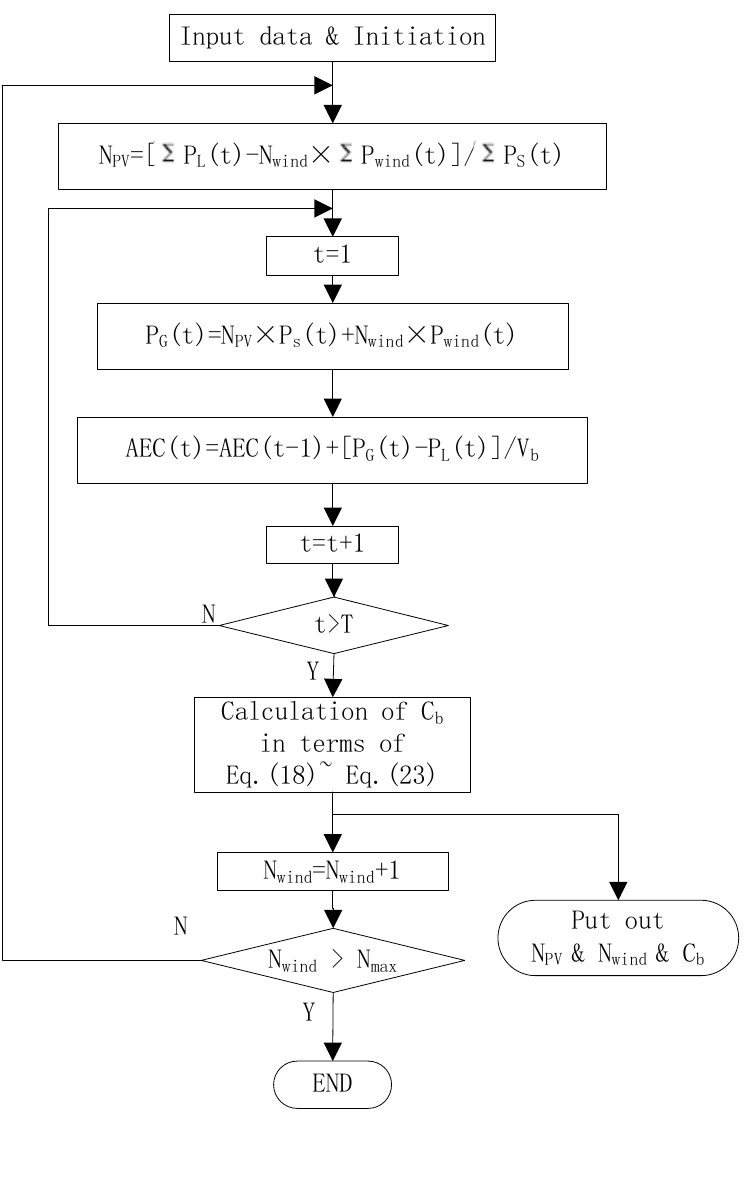
Figure 2. Flowchart of the algorithm for getting feasible